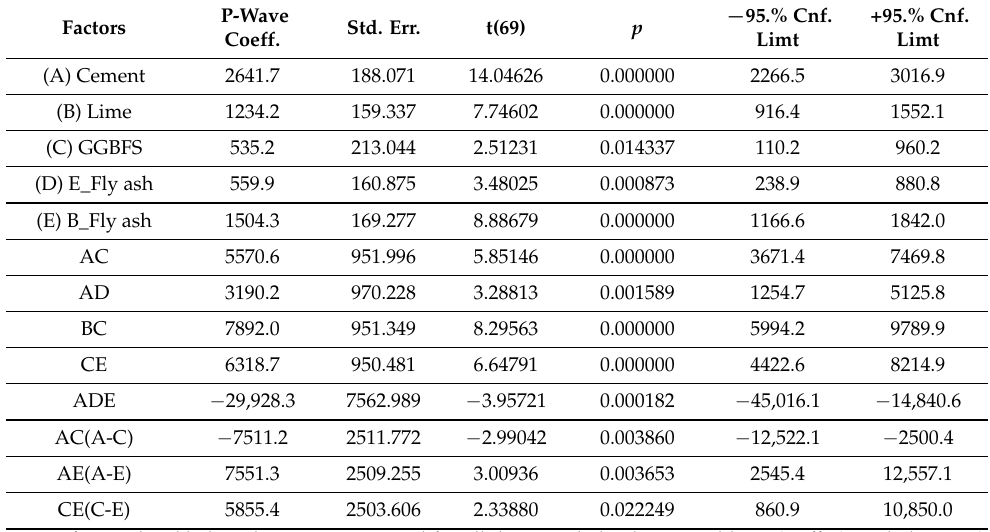
Table 6. Remaining significant effects on day 28th after the backward elimination.